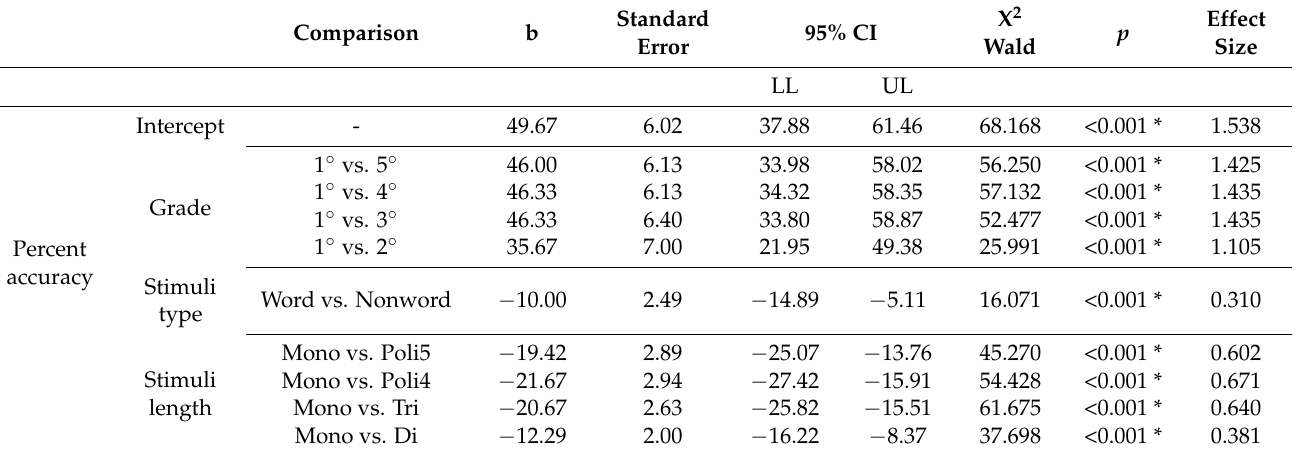
Table 4. Estimated GEE effects of grade, stimuli type and length on percent accuracy.